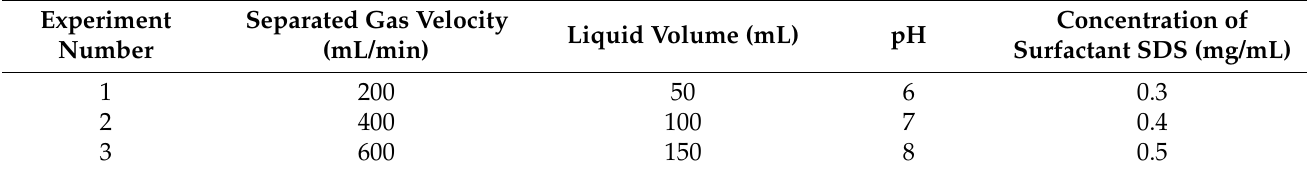
Table 1. Factors and levels of the orthogonal experiment for lipase in the fermentation broth.